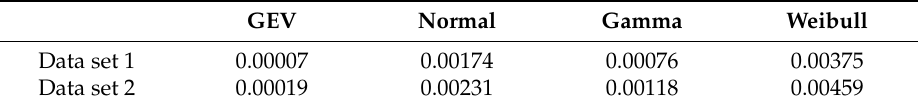
Figure 3. Probability density function (PDF) of normalized reflection symmetry and the fitted statistical distributions. ( a ) Data set 1; ( b ) data set 2. Table 2. Wasserstein distance for distribution fitting.